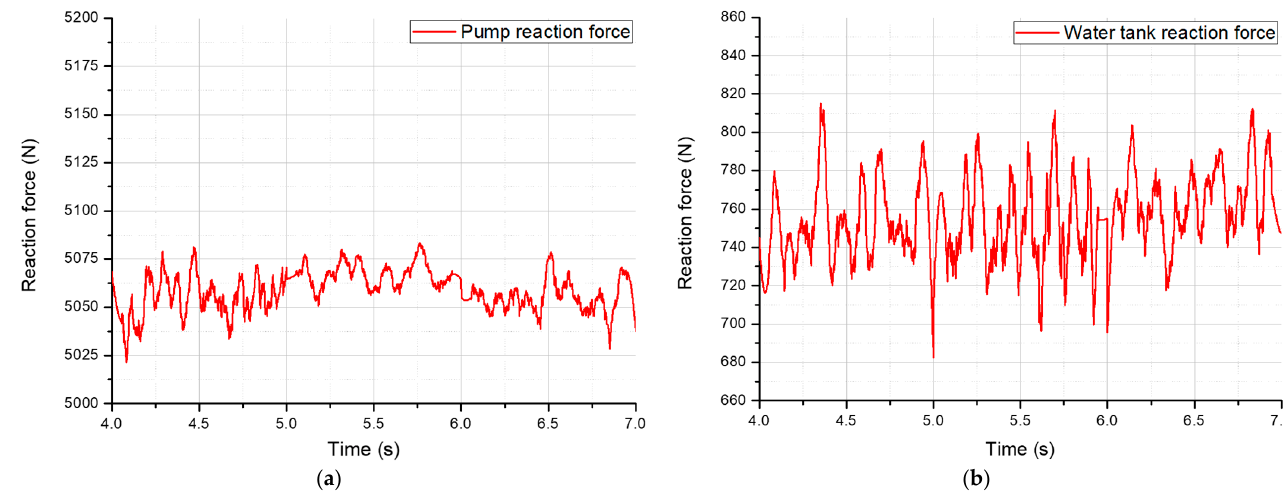
Figure 6. Reaction force data according to pump operation: ( a ) Pump reaction force in saturated state; ( b ) Water tank reaction force due to pump operation.